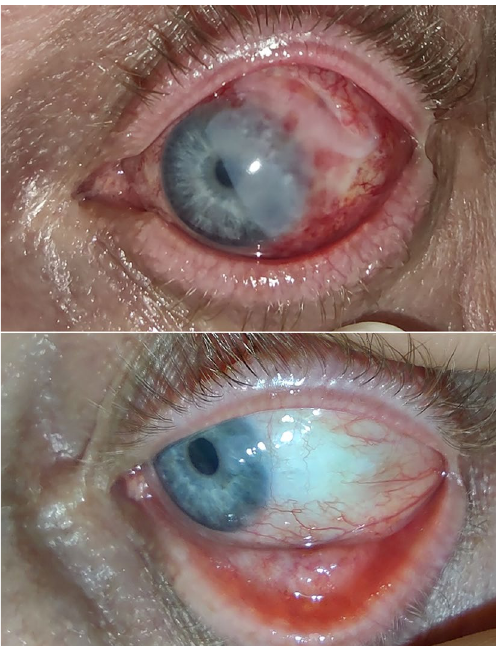
Figure 1. The anterior segment picture of patients 2 days (upper) and one year (lower) after epibulbar carcinoma surgery with the application of